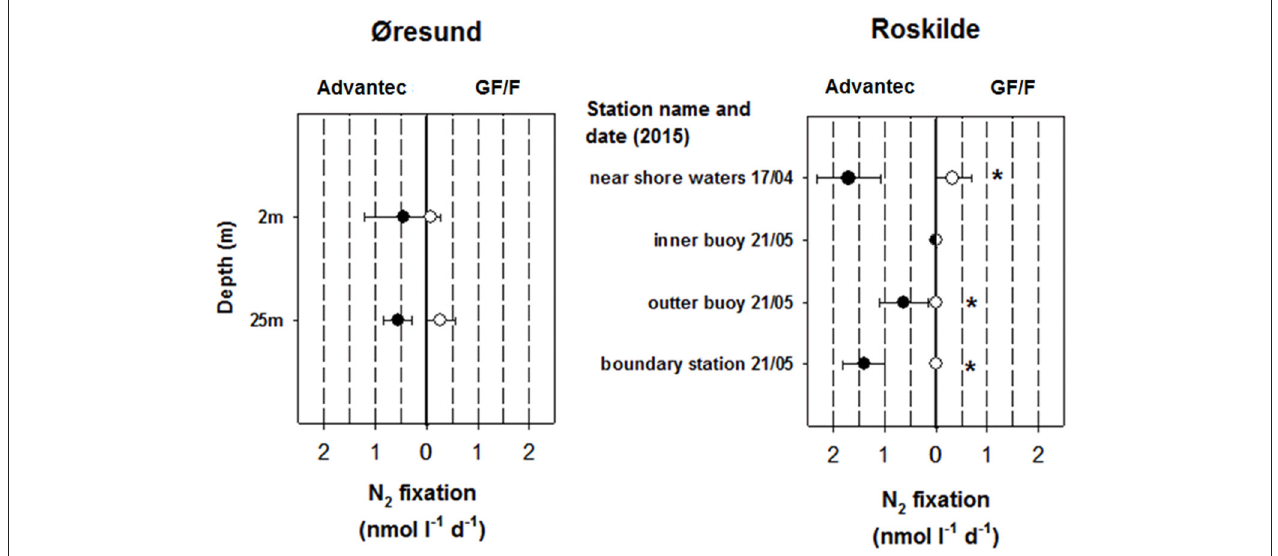
FIGURE 3 | N 2 fixation rates obtained from using Advantec or GF/F filters in Øresund and Roskilde Fjord (averages ± standard deviation, n = 3). N 2 fixation was undetectable in all Pacific samples and therefore a graph is not shown for that habitat. For Roskilde Fjord, N 2 fixation was not measured in March 2015. Cases where rates were significantly different between the two filter types are marked with asterisks ( t -test, p < 0.05). In Øresund, the halocline separates surface waters with a salinity of 11 and deep waters with a salinity of 33.